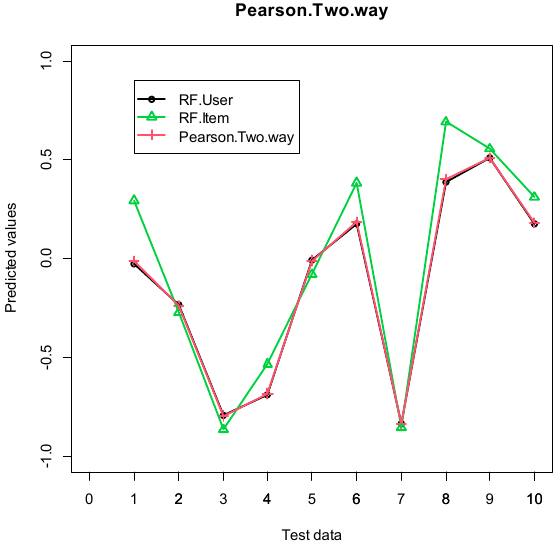
Figure 4. Predicted values for the RF Pearson correlation-based score.